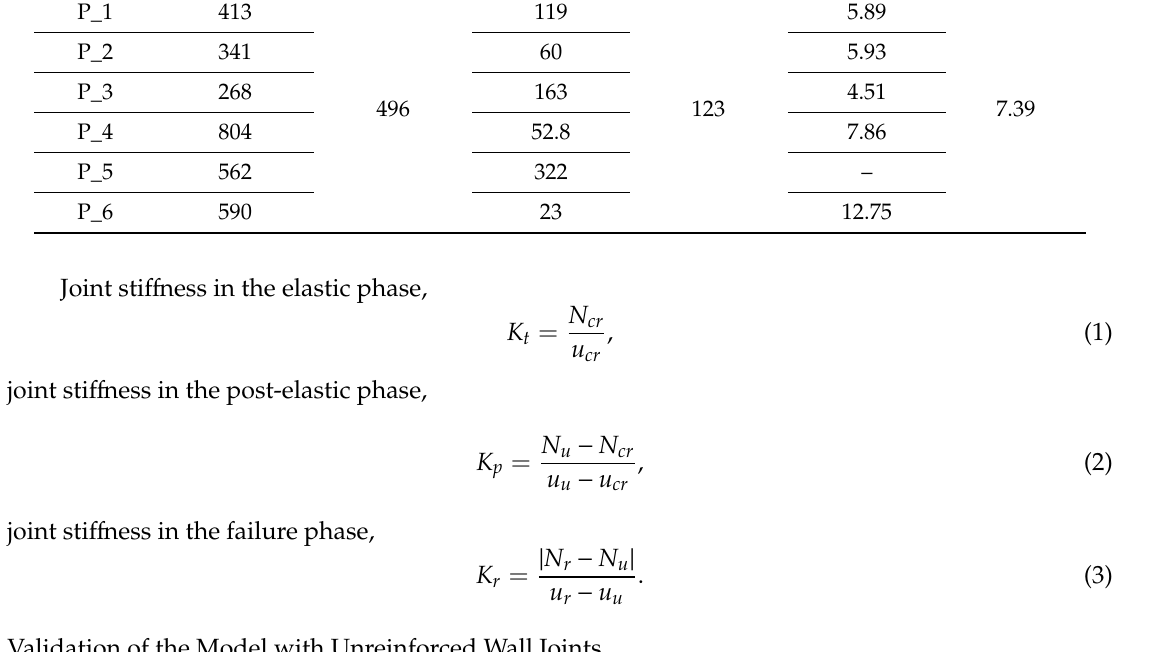
Table 4. Test results for joints between unreinforced walls (joint sti ff ness).